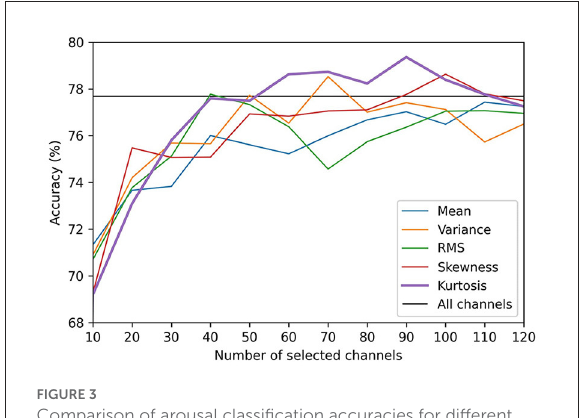
FIGURE3 Comparison of arousal classification accuracies for different EEG channel selection methods.